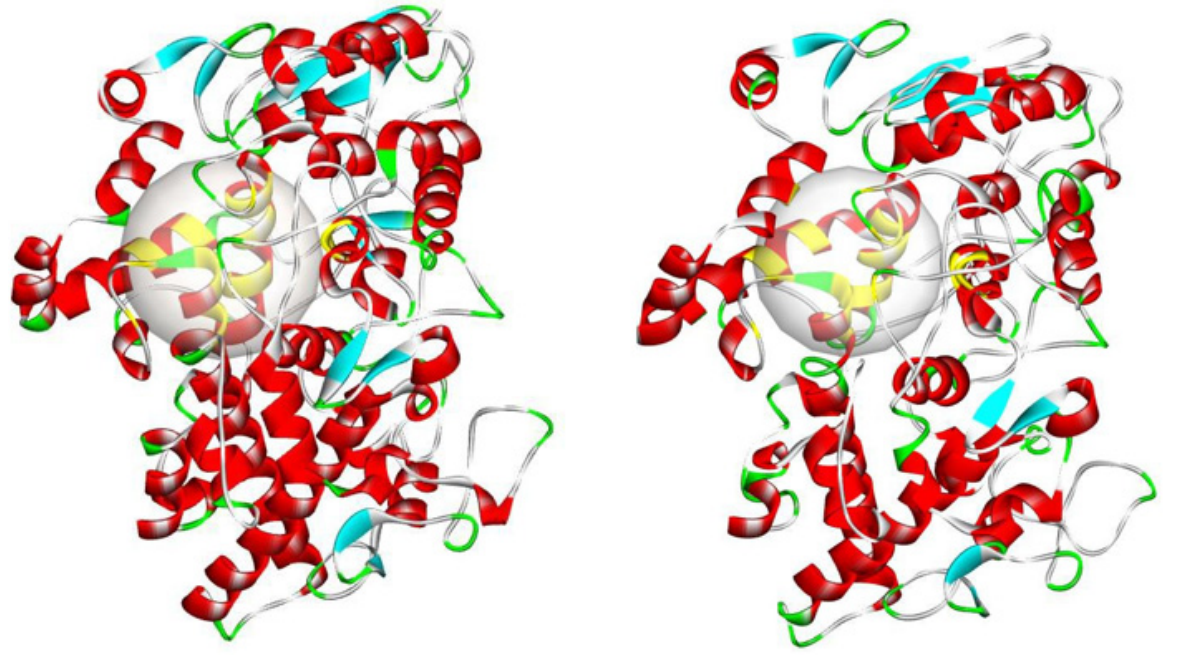
Figure 11. The plots of three-dimensional COX-1 (1EQG) and COX-2 (1CX2) are shown in the left and right panels. Each of them contains a grey sphere redefined as an active site with a 4 Å radius. The residues marked with yellow were suggested to be involved in the binding.